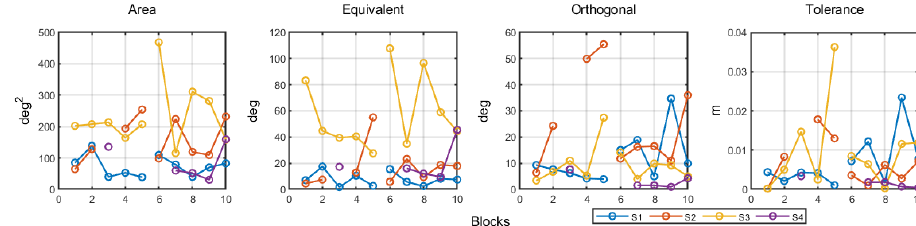
Figure 5. Area, equivalent variance, orthogonal variance, and tolerance cost for all participants over blocks and step height.